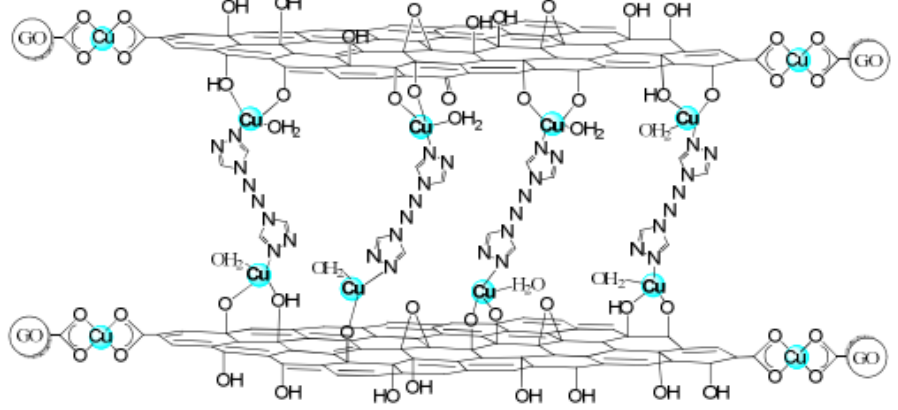
Figure 9. The structure of GO-Cu(II)-ATRZ ECP[83].